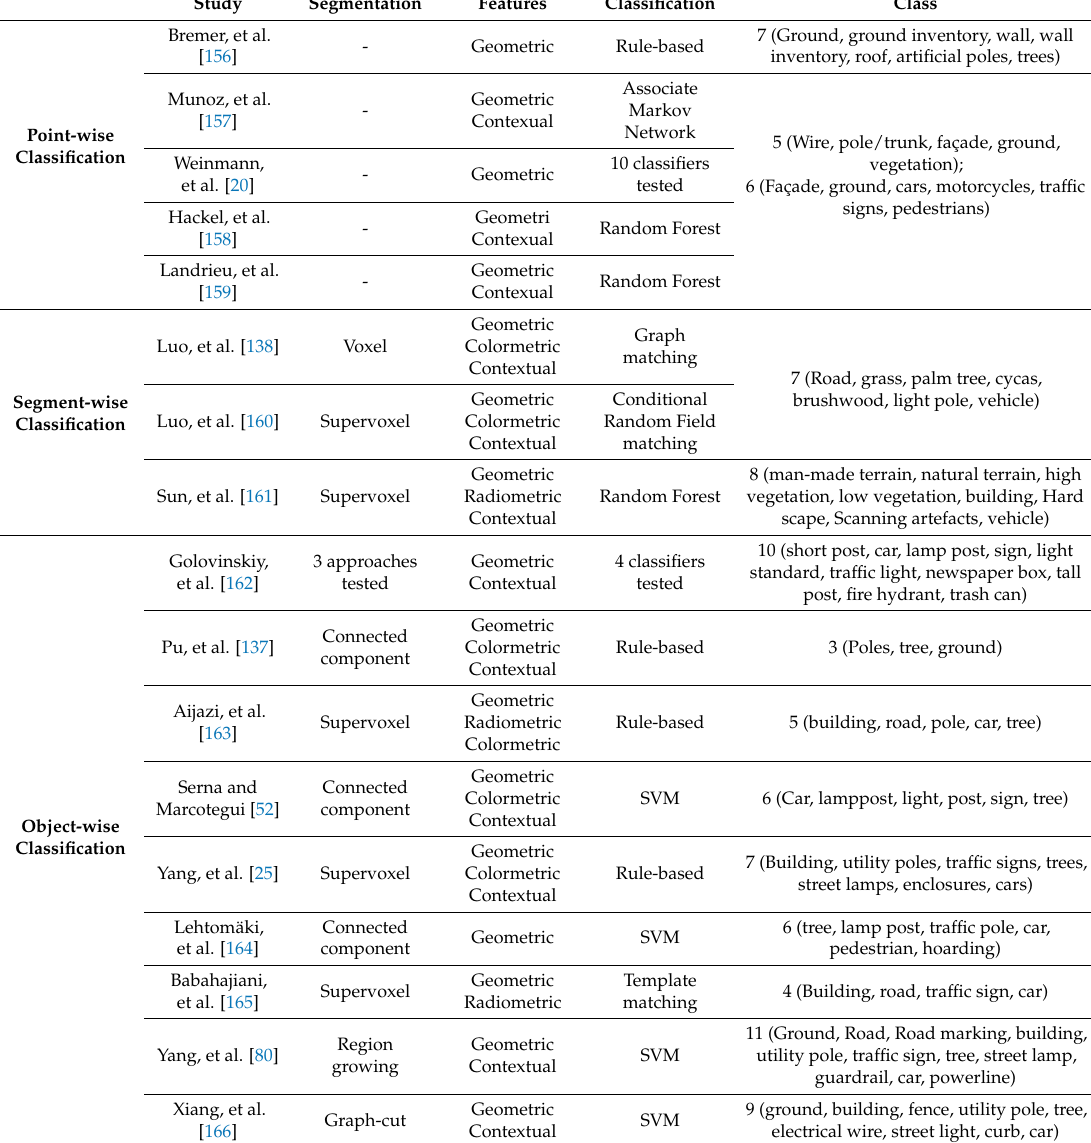
Table 8. Summary of the study on point cloud classification for MLS